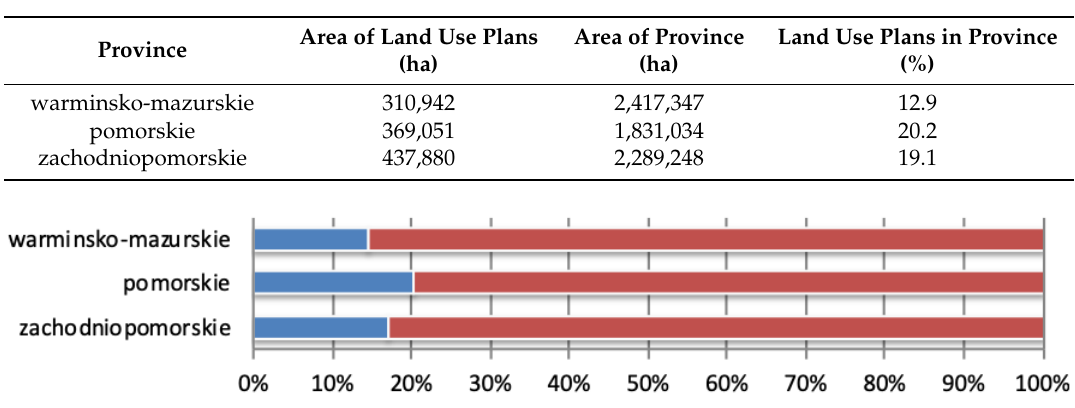
Table 5. Local land use plans in the provinces. Source: own study based on [55].